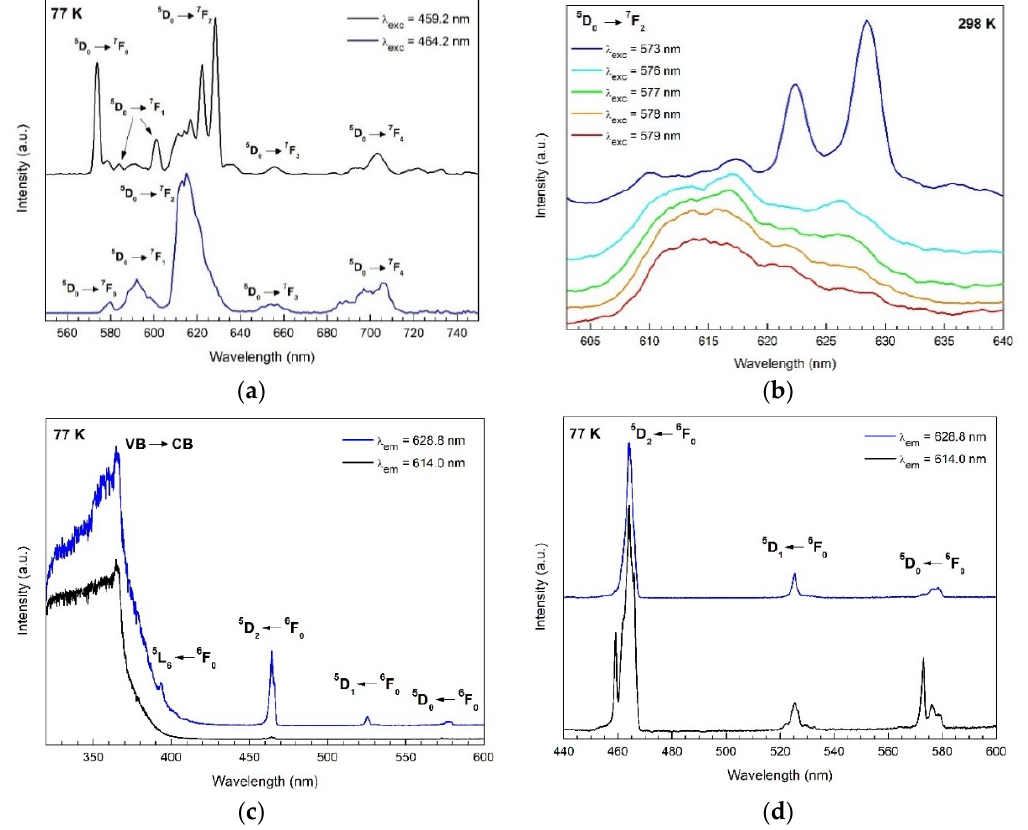
Figure 9. ( a ) Site-selective emission spectra of Eu 3+ ions in ZnO:Eu at 77 K; ( b ) Site-selective emission spectra of 5 D 0 → 7 F 2 transitions from Eu 3+ ions in ZnO:Eu at 298 K; ( c ) Site-selective excitation spectra of Eu 3+ ions in ZnO:Eu at 77 K; ( d ) Magnified spectra ( c ) in the 440–600 nm region. The transition 5 D 0 → 7 F 1 shows two bands at 583.8 and 601.0 nm. Related to the electric dipole transition 5 D 0 → 7 F 2 , three lines with the highest intensity are observed in the spectrum at 616.8, 622.4, and 628.2 nm. Notice that the left shoulder at 611.2 nm is due to the 5 D 0 → 7 F 2 transition from a different site of lower symmetry (see blue curve below Figure 9a). In general, the majority of 5 D 0 → 7 F J ( J = 0–6) transitions observed are of an electric dipole nature, except for the magnetic dipole 5 D 0 → 7 F 1 transition, for which intensity is independent to the site symmetry. According to the Judd–Ofelt theory, electric dipole transitions are only allowed for a Eu 3+ ion at a site without a center of symmetry (inversion center). Therefore, from the 32 crystallographic point groups, the 21 meeting this criterion are: C 6 , C 6 v , D 6 , D 3 h , D 3 , C 3 v , C 3 h , C 3 , D 4 , C 4 v , C 4 , S 4 , D 2 d , D 2 , C 2 v , C 2 , C s , C 1 , O , T d , and T [59]. Additionally, according to the electric dipole selection rule, the 5 D 0 → 7 F 0 transition is only allowed for the following 10 site symmetries, C s , C 1 , C n , and C nv ( n = 2, 3, 4, 6) [60,61]. Therefore, the only point groups without an inversion center and showing one band for the 5 D 0 → 7 F 0 transition, two bands for the 5 D 0 → 7 F 1 transition and three bands for the 5 D 0 → 7 F 2 transition are C 3 and C 3 v . Since Zn 2+ ions are located at a lattice site with C 3 v symmetry in the ZnO crystal lattice, the results confirm the successful incorporation of europium by the substitution of Zn 2+ ions. In the spectra under excitation at 464.2 nm (blue curve in Figure 9a), broader emission bands are observed. The unresolved and inhomogeneous broadening is an indication of the existence of multiple non-equivalent sites of Eu 3+ ions with lower symmetry. Looking at the space group P 6 3 mc of hexagonal ZnO, an additional cation site for Eu 3+ ions can be the 6 c Wyckoff position with a C s point group symmetry in Schoenflies notation ( m point group symmetry in Hermann-Mauguin notation) [62]. Based on the theoretical branching